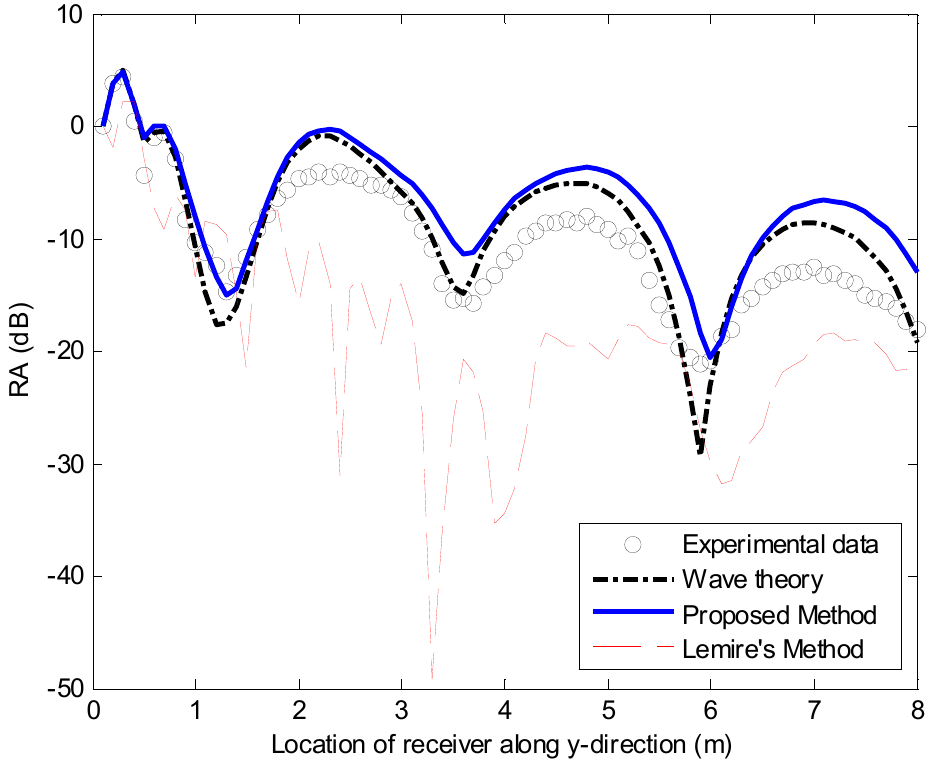
Figure 7. Comparison of measurements and predictions on relative attenuation (RA) at a frequency of 1000 Hz vs. the receiver location along the y -direction inside a scale-model long rectangular space. The circles represent the experimental results averaged from several measurements, the dash-dotted line represents the prediction results with the wave theory, the solid line denotes those with the proposed method, and the dash line is the result with the method of Lemire and Nicolas (Lemire’s method).